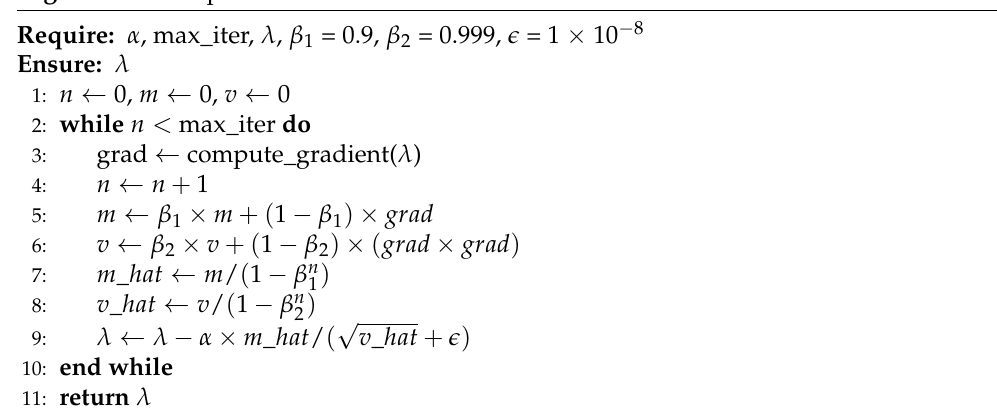
Algorithm 5 Adaptive Stochastic Gradient